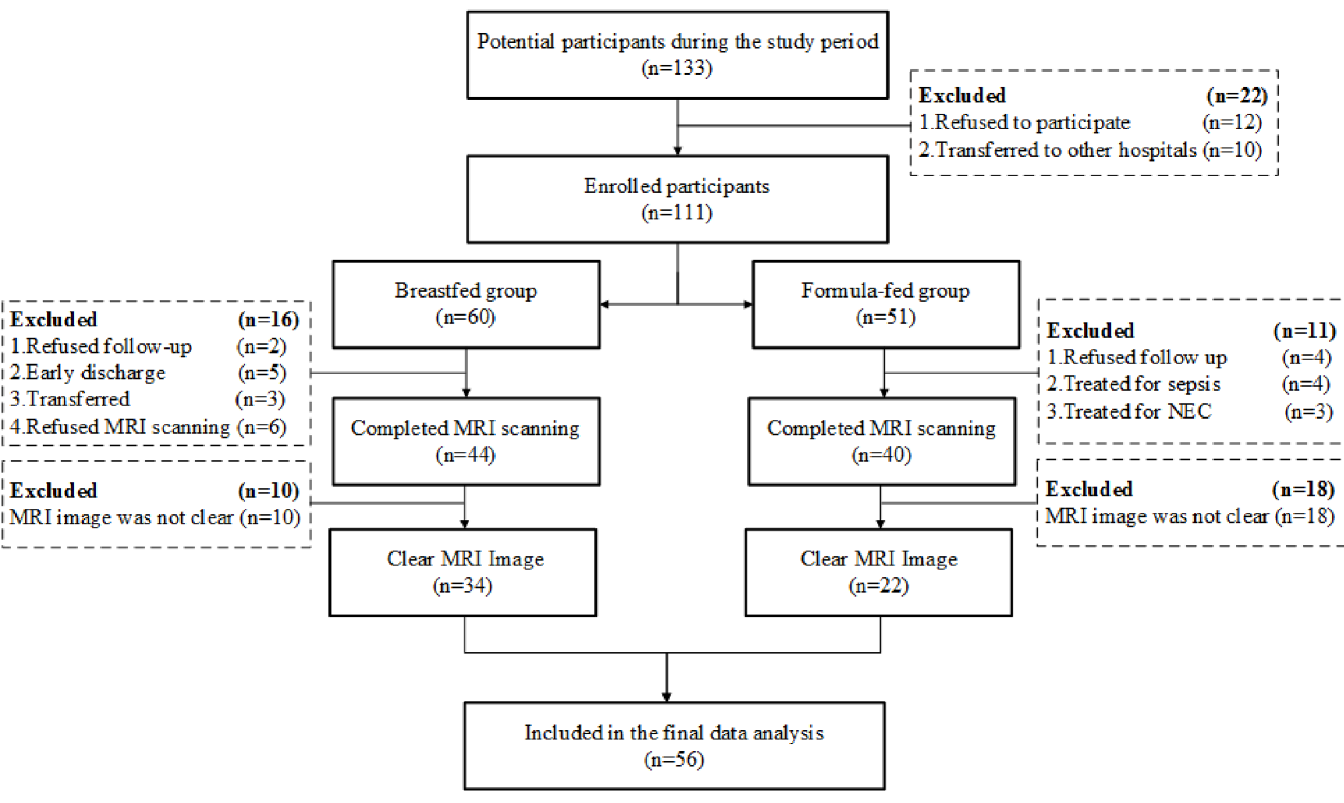
Fig 1. Flow chart showing the recruitment details of the